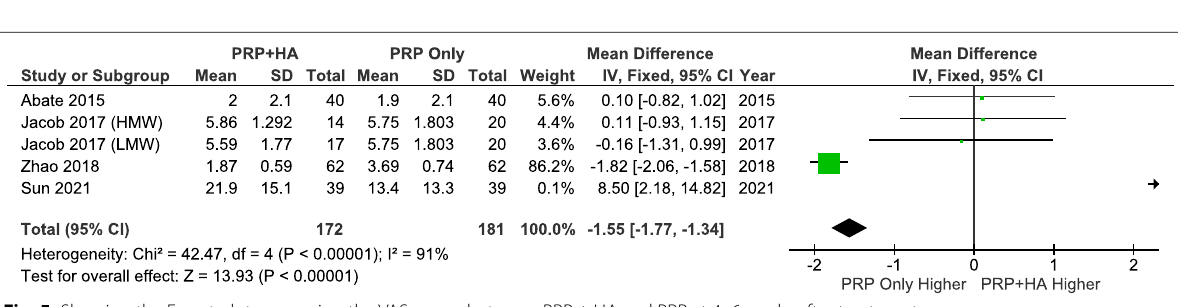
HA and PRP at 4–6 weeks after +